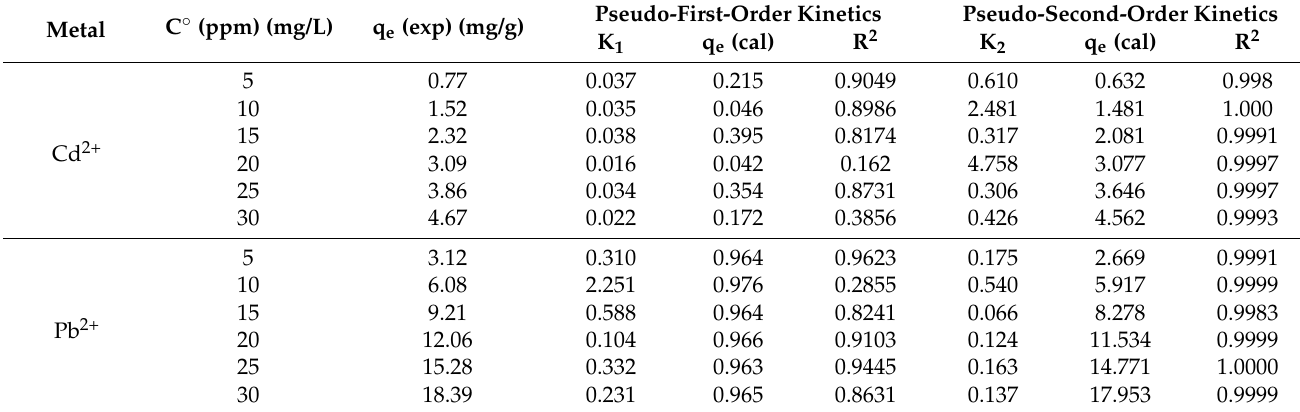
Table 5. Kinetic parameters calculated for Cd 2+ and Pb 2+ adsorption onto ZnO-NPs via different models. Pseudo-First-Order Metal C ◦ (ppm) (mg/L) q e (exp) (mg/g)